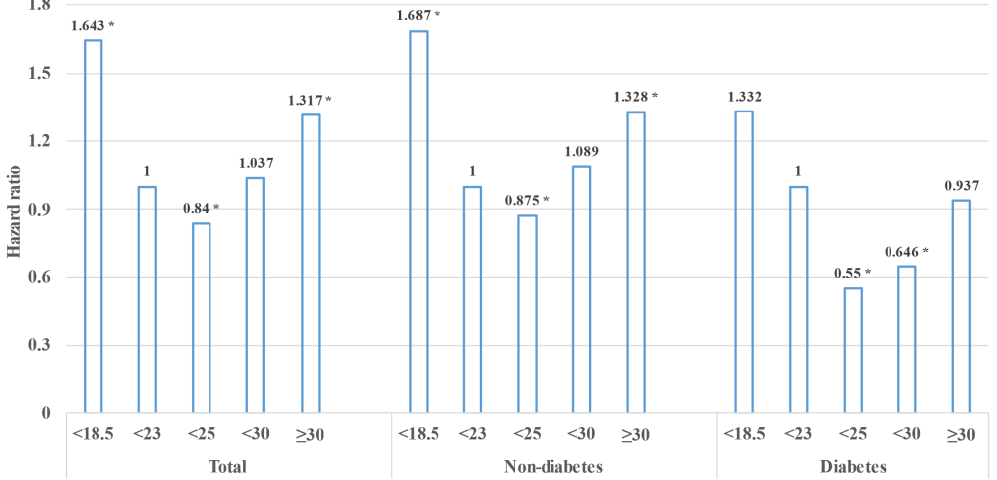
Figure 3. Adjusted hazard ratios of acute pancreatitis in subjects with constant BMI. Adjusted for age, sex, alcohol consumption, smoking, type 2 diabetes, insulin administration, hypertension, dyslipidemia, chronic kidney disease, chronic pancreatitis, regular physical activity, and low income. * Statistically significant.